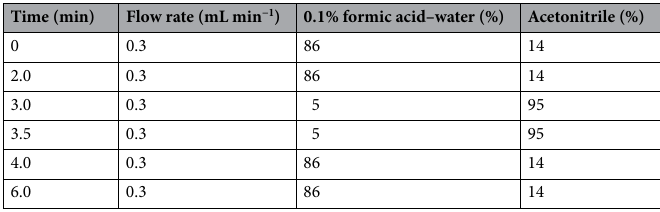
Table 3. Mobile phase gradient elution procedure.